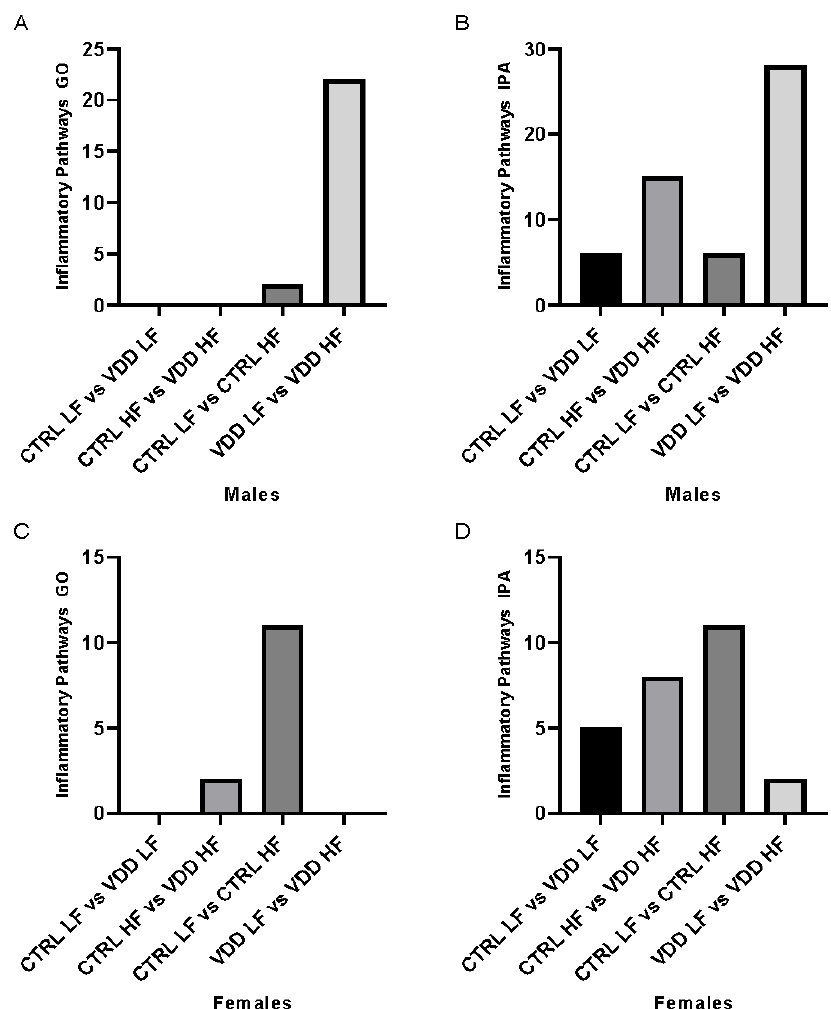
Figure 2. Inflammatory pathways linked to RNA profile in adipose tissue of the offspring. Quantitative representation of inflammatory pathways resulting in differential gene expression in retroperitoneal adipose tissue of the male offspring ( A , B ) and female offspring ( C , D ) using Gene Ontology (GO) and Ingenuity Pathway Analysis (IPA). Two sets of data were employed. The first is CTRL LF vs. VDD LF and CTRL HF vs. VDD HF. The second data is CTRL LF vs. CTRL HF and VDD LF vs. VDD HF. The genes were originally chosen based on the following criteria: padj < 0.01 and fold change FC > 1.5 or − 0.66.